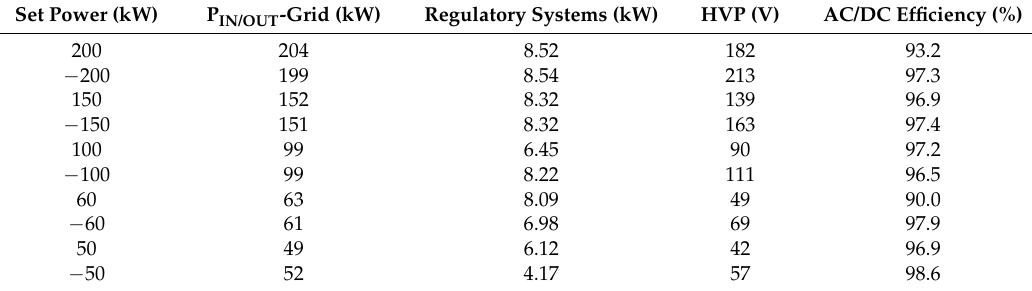
Table 3. Regulatory system power requirement at various charge and discharge power levels with resulting AC/DC efficiencies recorded from the human–machine interface (HMI).